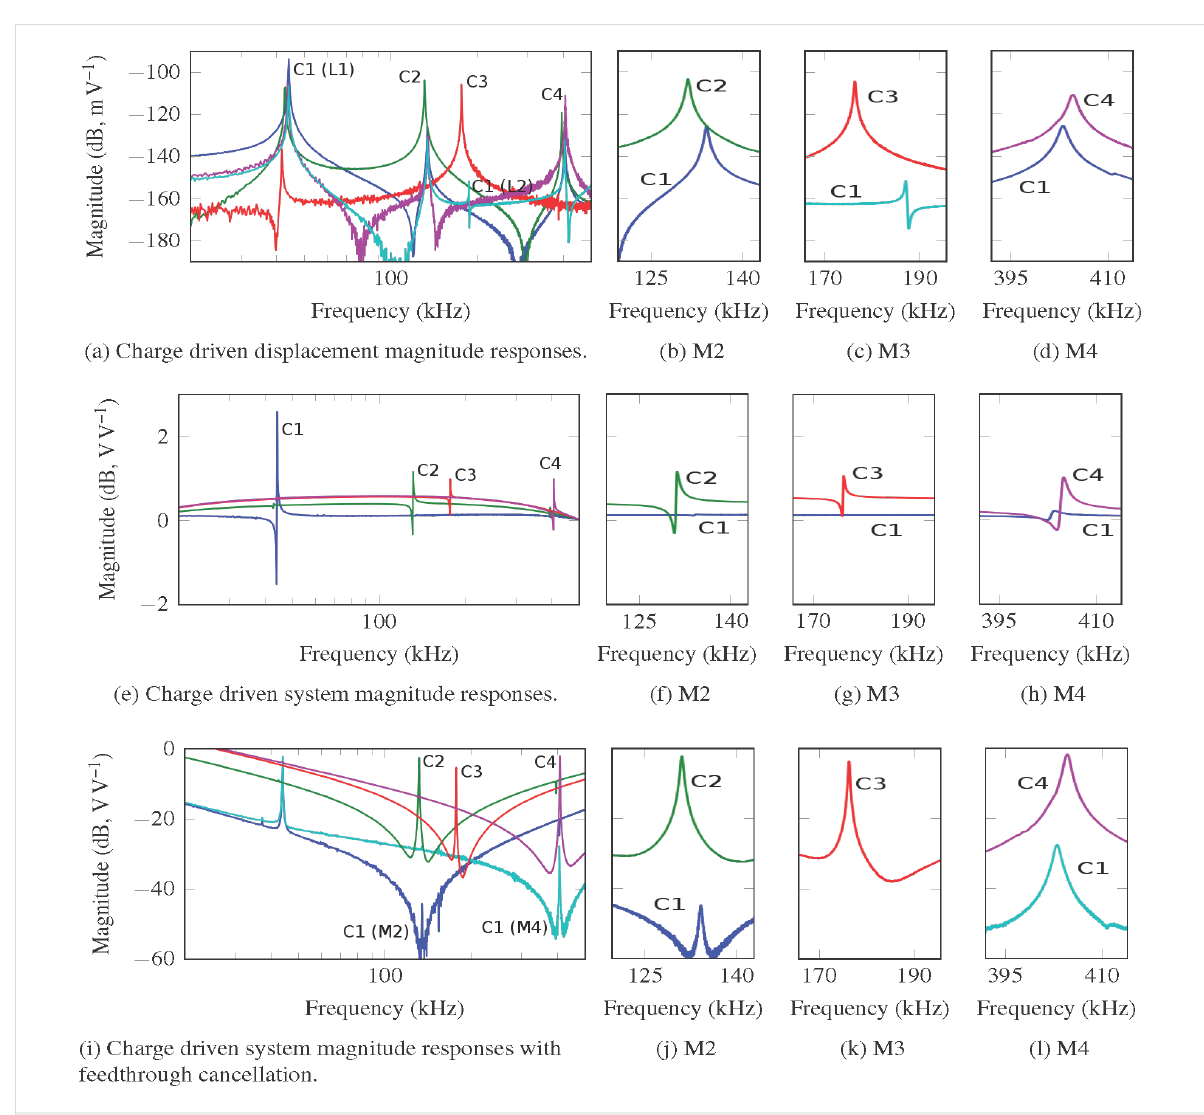
Figure 7: Charge driven magnitude responses of the cantilevers C1–C4. (a)–(d) The responses from input voltage V i to displacement d . The flexural modes of C1, C2, and C4 are measured at location 1 (L1). The torsional modes of C1 and C3 are measured at location 2 (L2) (see Figure 2m). (e)–(h) The responses from V i to output voltage V o . To show the resonance more clearly, the plots for C1–C4 are moved to 0 dB with a shift of − 3.984 dB, − 12.42 dB, − 14.46 dB and − 14.50 dB respectively to account for the affect of different values of C p in each cantilever. (i)–(l) The responses from V i to sensor output V d . (b)–(d), (f)–(h) and (j)–(l) show higher resolution plots of the